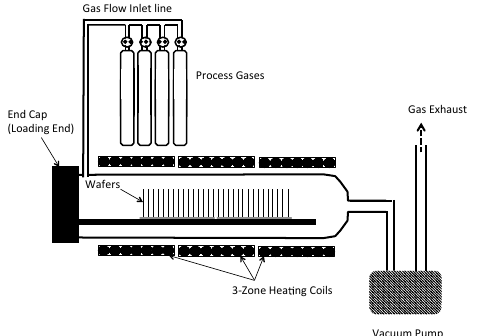
Figure A3. A low-pressure chemical vapor deposition (LPCVD) system.